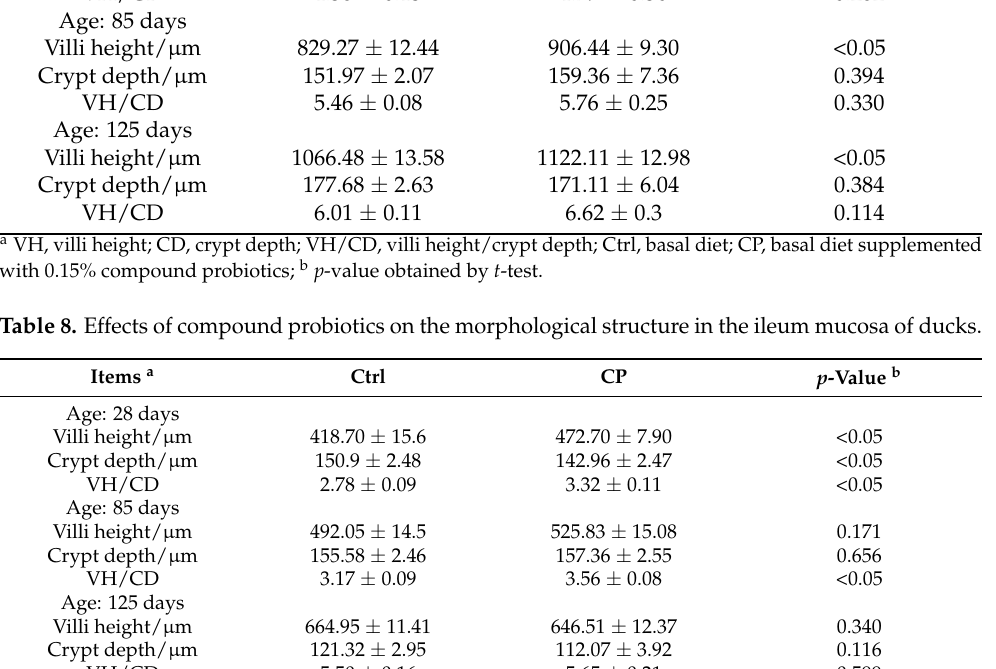
Table 7. Effects of compound probiotics on the morphological structure in the jejunum mucosa of ducks.